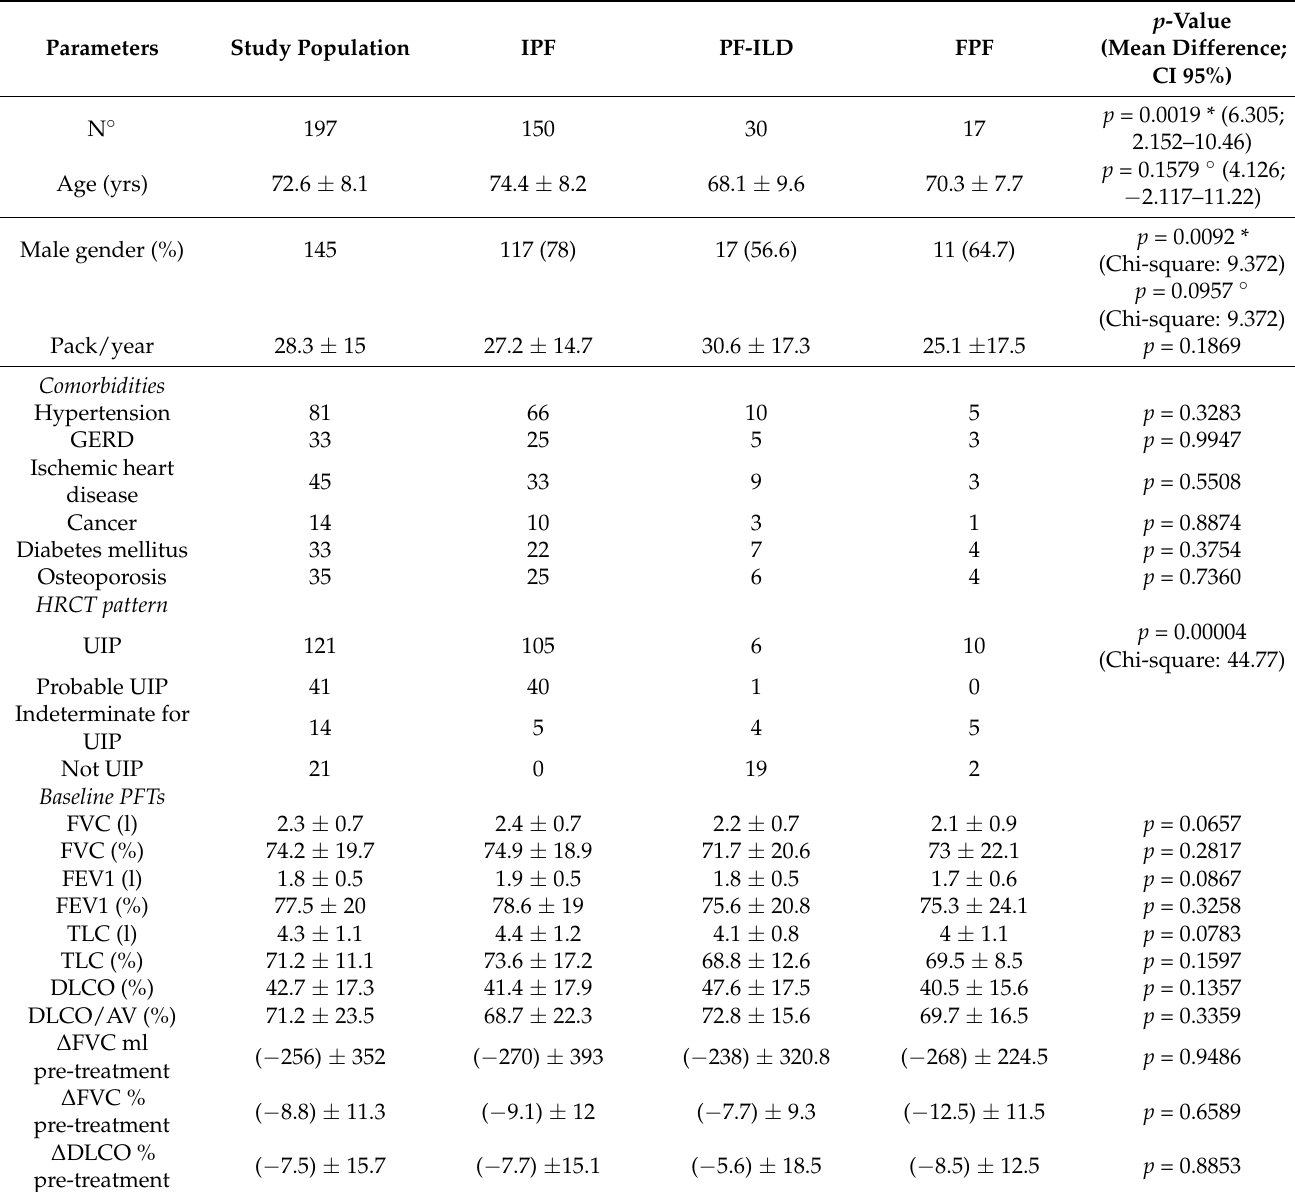
Table 1. Demographic features, clinical data, respiratory functional parameters and radiological pattern of the entire study population and among the three subgroups. * Post test comparison between PF-ILD and IPF; ◦ post test comparison between FPF and IPF